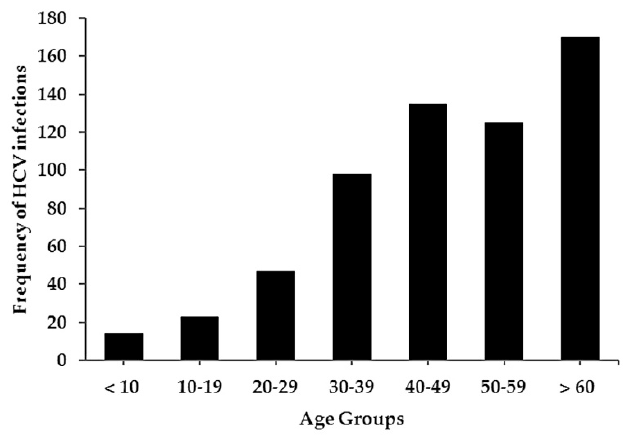
Figure 2. Frequency of incidence of HCV infection among different age groups. The frequency of anti-HCV positive individuals was found to be different among different nationalities. The largest proportion of infection was found among Libyans (553 cases, 90.4%), followed by Egyptians (50 cases, 8.2%), Syrians (6 cases, 1%), Sudanese (2 cases, 0.3%), and a Ghanaian (1 case, 0.1%). The frequency of anti-HCV positive individuals according to geographical regions was varied; the majority of cases being from Tobruk region (506, 82.7%), followed by Darnah city (53, 8.7%), Al-Bayda city (27, 4.4%), Banghazi (14, 2.3%), and sporadic cases from other nearby cities (12, 1.9%). The rate of anti-HCV positive individuals has declined steadily over the study period, especially in the last decade ( p < 0.05) (Figure 3). Figure 3. Trend line of anti-HCV positive cases over the study period. 3.2. Follow Up Detection of HCV-RNA and Linkage to Care and Treatment By interviewing the public health personnel in the Medical Center and assessing test- ing procedures for HCV infection, it was discovered that the HCV–Ribonucleic acid (RNA) confirmatory test among anti-HCV positive individuals was not done. In addition, no working polymerase chain reaction (PCR) for HCV–nucleic acid detection was found in the Medical Center. Moreover, anti-HCV positive individuals were not linked to out- patient care and treatment.